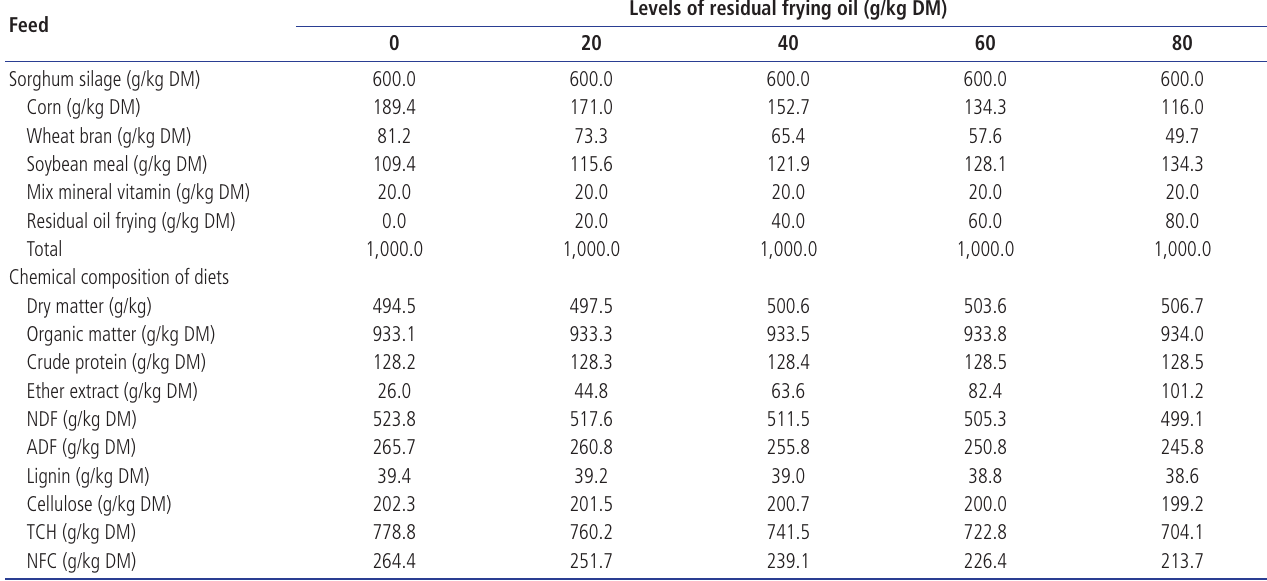
Table 1. Food and chemical compositions in dry matter basis of diets containing different levels of residual frying oil for lambs